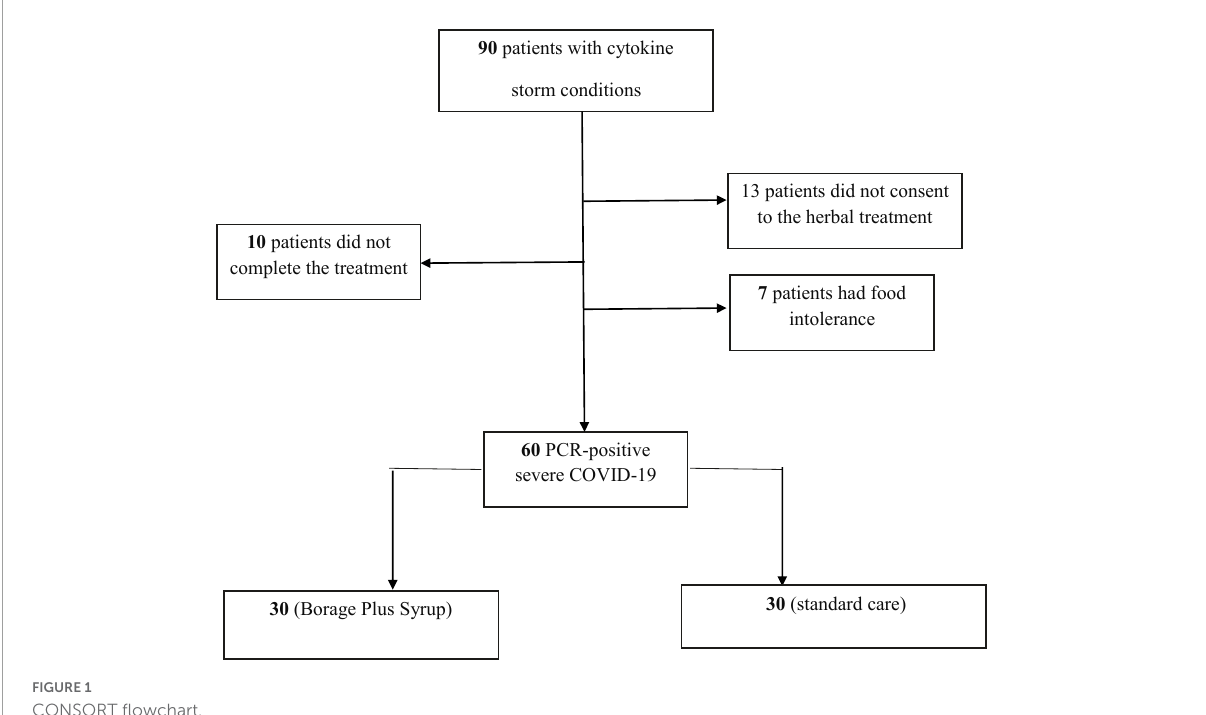
FIGURE1 CONSORT